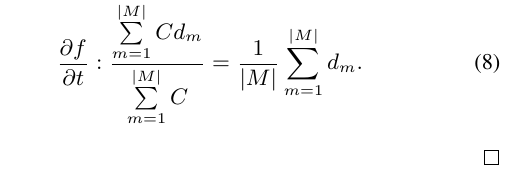
Algorithm 1 states the described procedure in four steps and is